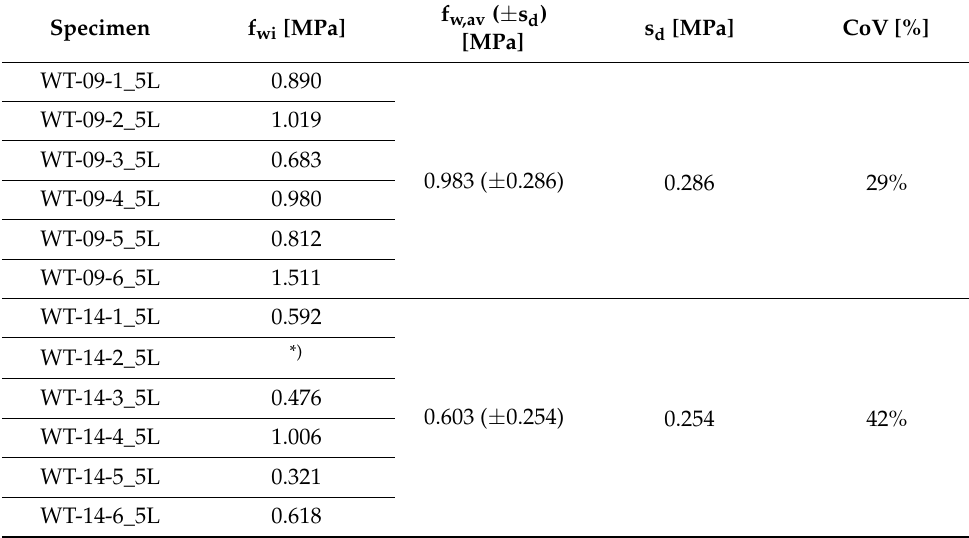
Table 6. Bond strength results for series using 5 L of mixing